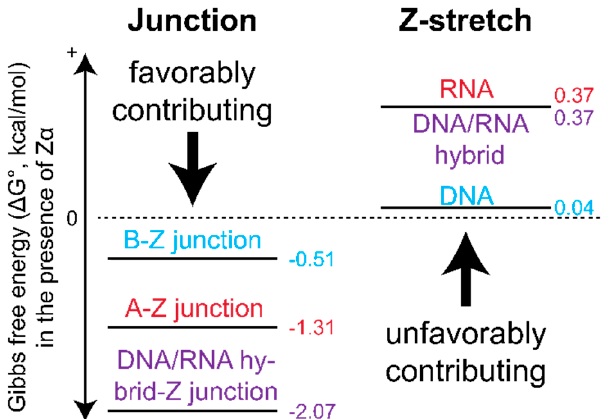
Figure 14. Energetics of junction formation. Junction formation dominates free energies of Z-conformation adoption and largely drives the transition in the presence of protein. DNA/RNA hybrid junction formation is the most energetically favorable, followed by A-Z junctions, and then B-Z junctions. CpG Z-formation is unfavorable in every case but is lowest for DNA and equivalent for RNA and DNA/RNA hybrids. All ∆ G values reported from